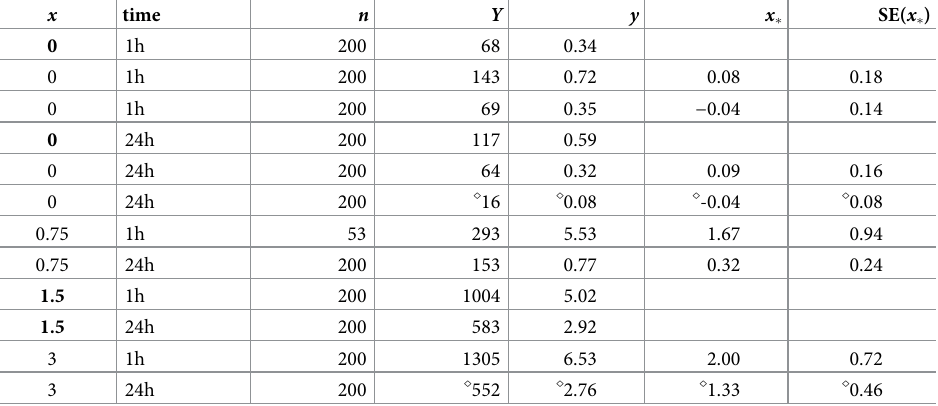
Table 4. Data from Section 5.1. Rows in bold print are considered as reference information. The first column gives the true, known doses (which are only made use of for the reference samples). Dose estimates and standard errors are provided in the final two columns. Yields associated with a � symbol were obtained by a different scorer, in the same